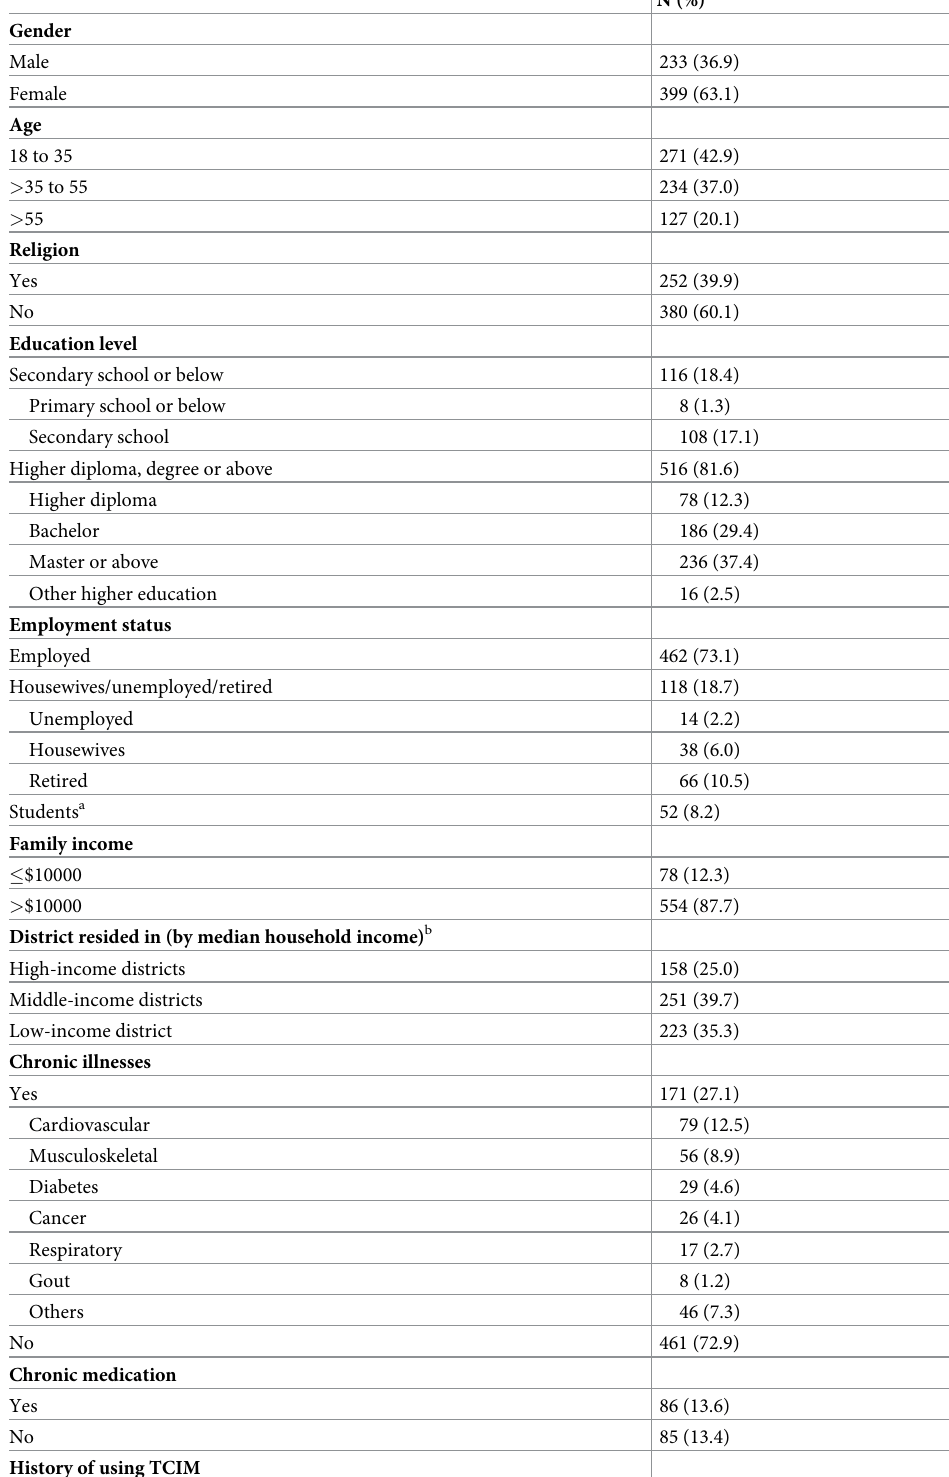
Table 1. Characteristics of TCIM user and non-user during COVID-19 (n =